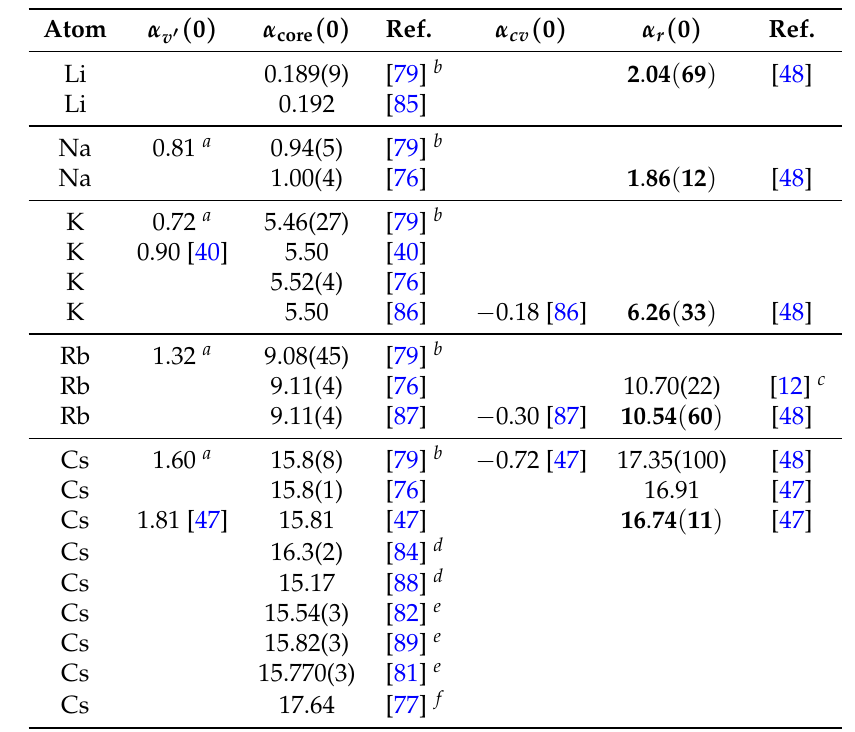
Table A1. Contributions to residual polarizability α r ( 0 ) = α v (cid:48) ( 0 ) + α core ( 0 ) + α cv ( 0 ) in atomic units. The quantity α v (cid:48) ( 0 ) is the sum of all the contributions from the valence electron ns - n (cid:48) p J transitions with n (cid:48) > n using Equation (1). This includes α tail ( 0 ) . Values in bold are used to produce the results presented in Table